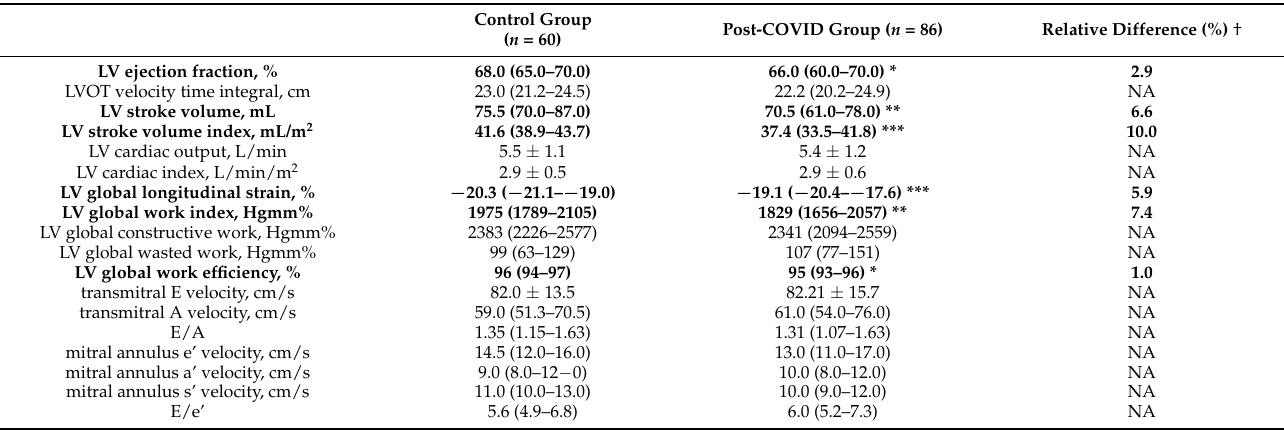
Table 3. Echocardiographic parameters of the systolic and diastolic function of the left atrium and left ventricle in the study